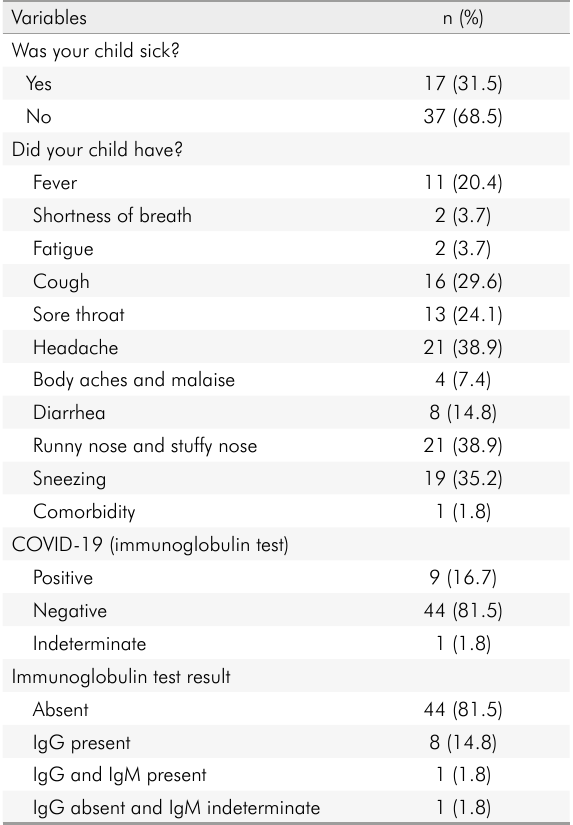
Table 2. Signs and symptoms of COVID-19 and neutralizing proteins (IgG and